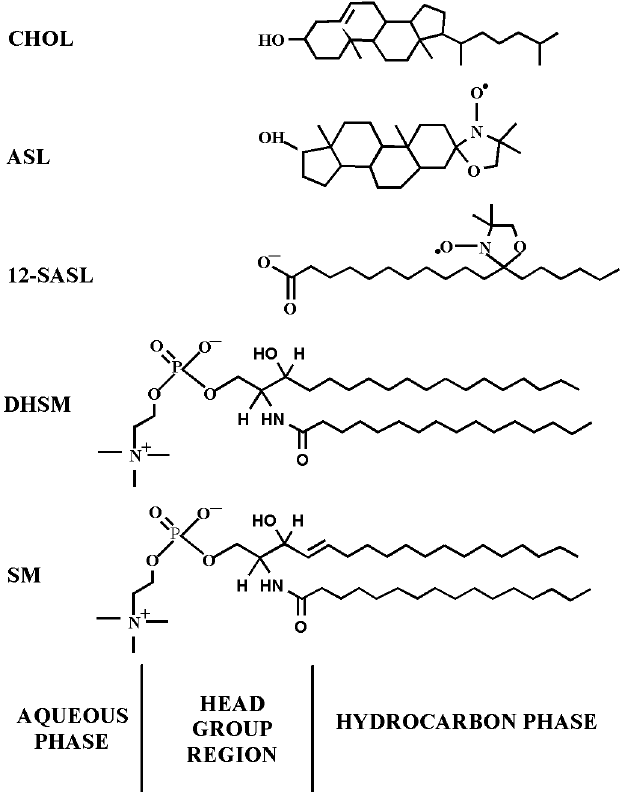
Figure 1. Chemical structures of spin labels used and their approximate locations in the lipid bilayer membrane. The PL analog 12-SASL and the Chol analog ASL, respectively, model the properties of the membrane PLs acyl chain region and the behavior of Chol molecules in the lipid bilayer. Chemical structures of palmitoyl sphingomyelin (SM) and palmitoyl dihydrosphingomyelin (DHSM), the most abundant lipids in human lens membranes [40], are also presented.